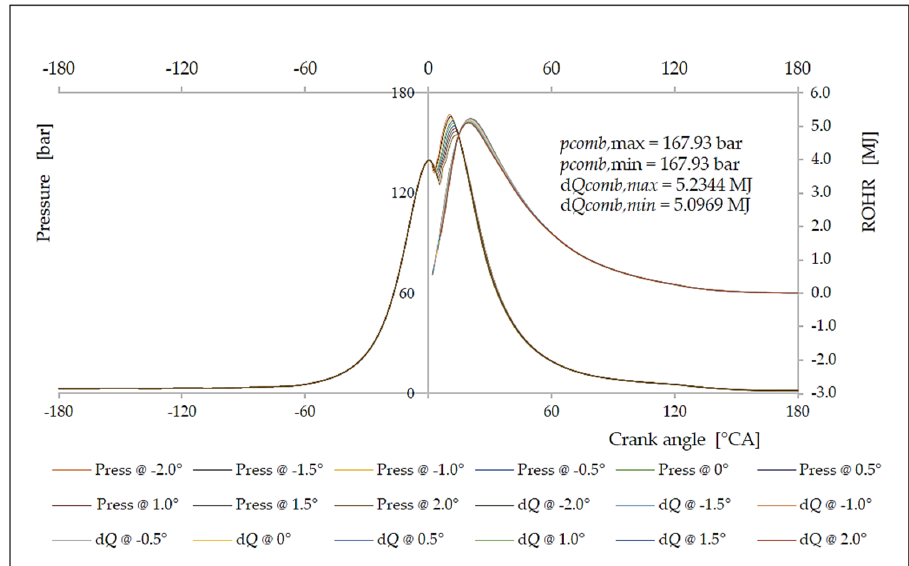
Figure 9. Pressure and heat release changes due injection timing changes at 75% MCR [22].